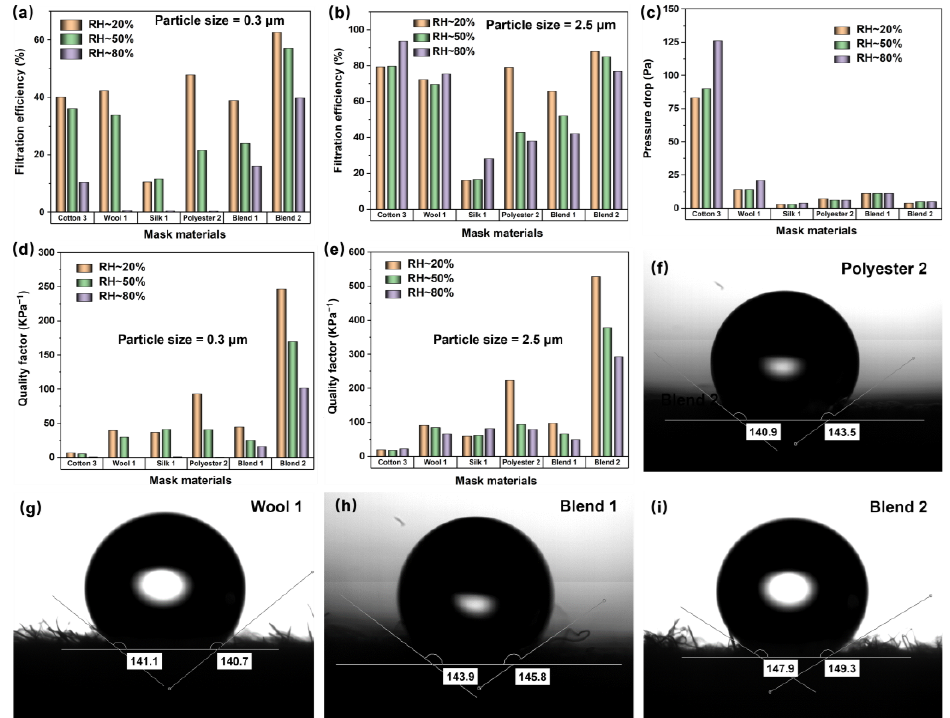
Figure 4. ( a , b ) Filtration efficiency, ( c ) pressure drop, and ( d , e ) quality factor of six fabrics at particle size of 0.3 um and 2.5 μm . Water contact angle of ( f ) Polyester 2, ( g ) Wool 1, ( h ) Blend 1, and ( i ) Blend 2 fabrics.